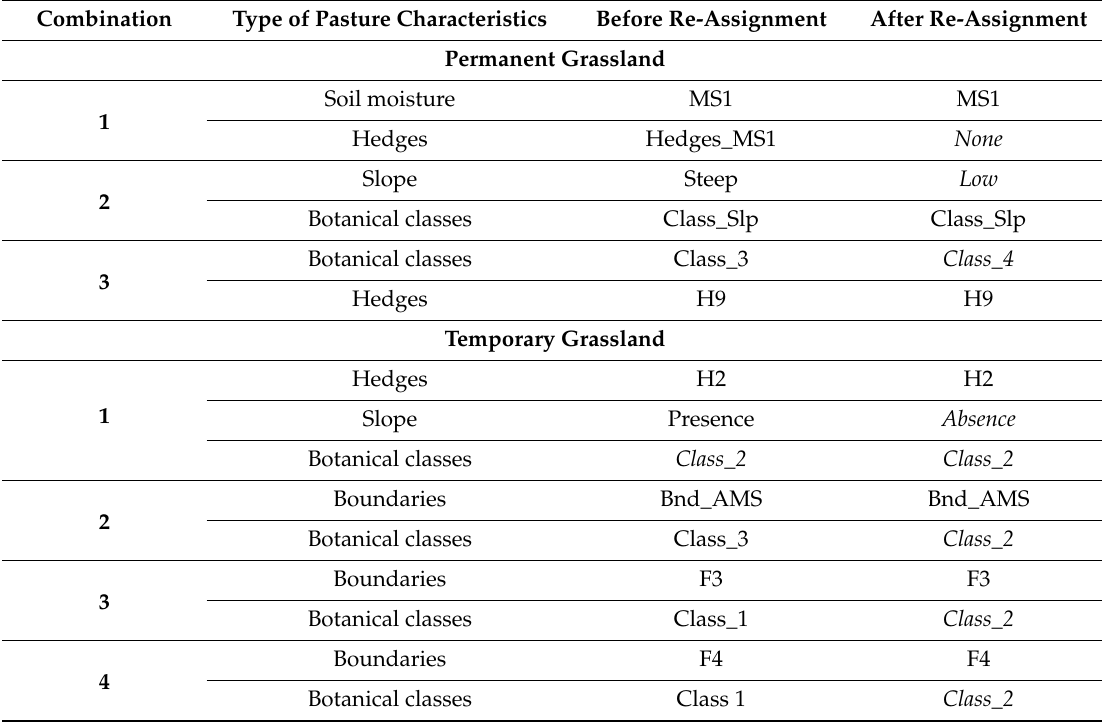
Table A2. Re-assignment to prevent the correlation between the di ff erent types of pasture characteristics and explanation of the method